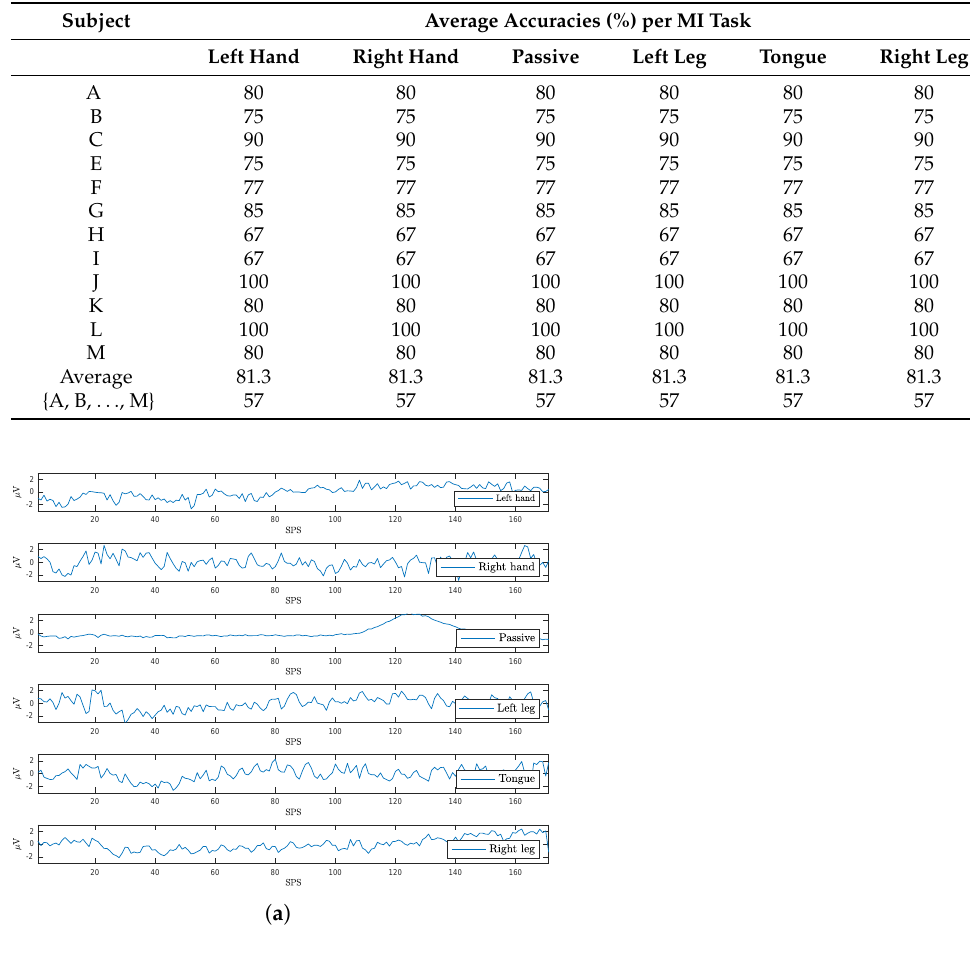
Table 9. Summary of confusion matrices’ diagonal results classifying MI tasks separately. The average accuracies per MI task do not include “{A,B, . . ., M}” subjects. The CMIbA was used for that purpose.